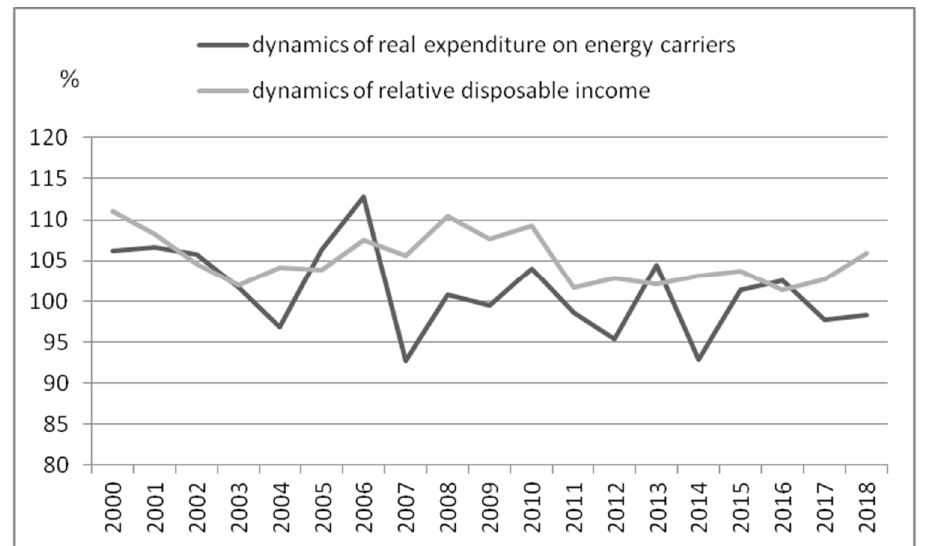
Figure 4. Changes in real disposable income and real expenditure on energy carriers in one-person households in 2000–2018. Comment: Real expenditures in energy carriers: p = 0.0584, the slope of a trend line = − 0.4064, coefficient of determination R 2 = 0.1950; relative available income: p = 0.0540, the slope of a trend line = − 0.2437, coefficient of determination R 2 = 0.2013. Source: own study and calculations based on Central Statistical Office data.